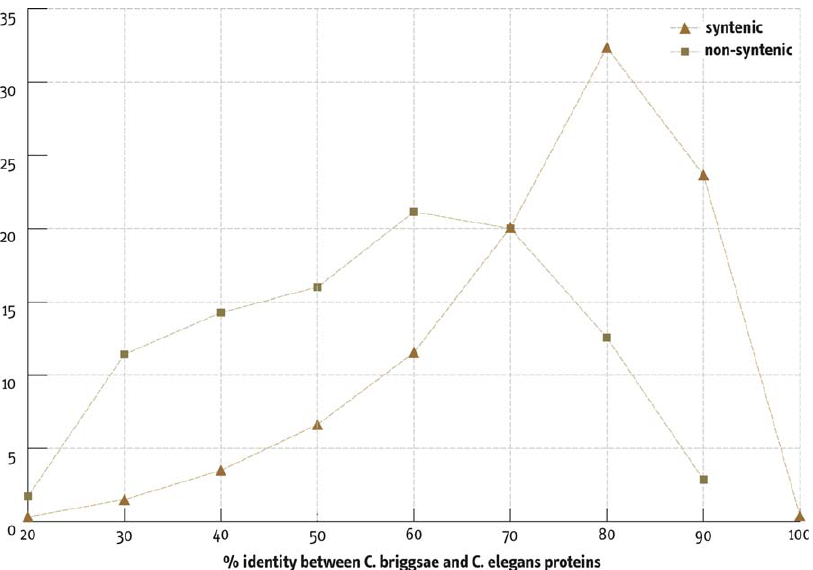
Figure 6. Sequence Similarity of Syntenic and Nonsyntenic Ortholog Pairs Syntenic and nonsyntenic ortholog pairs differ in their sequence similarity. The distribution of the percent identity, binned in five percentile bins, is shown both for pairs on the same chromosome (syntenic) and on different chromosomes